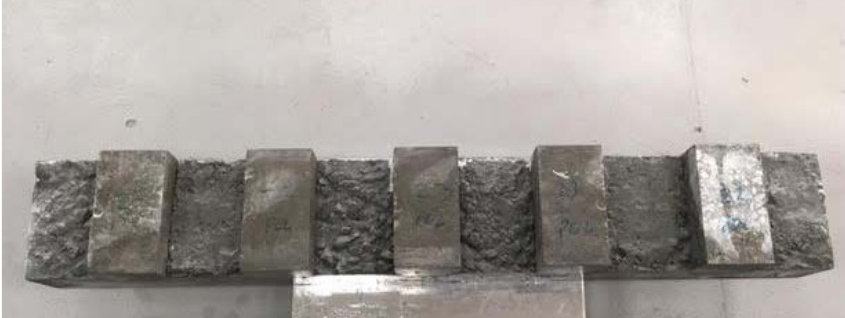
Figure 13. Prepared sample for bending strength testing.